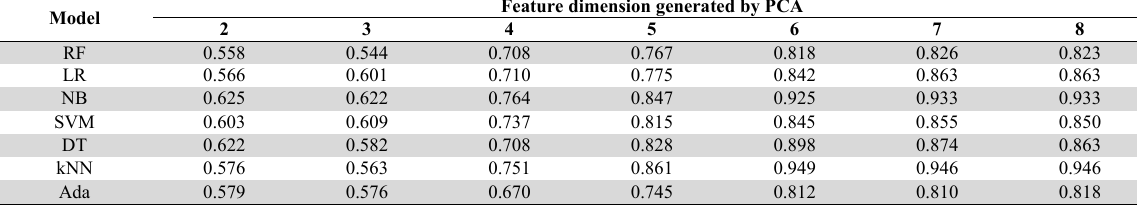
Results of Recall evaluation measure against different feature dimensions generated by PCA Model